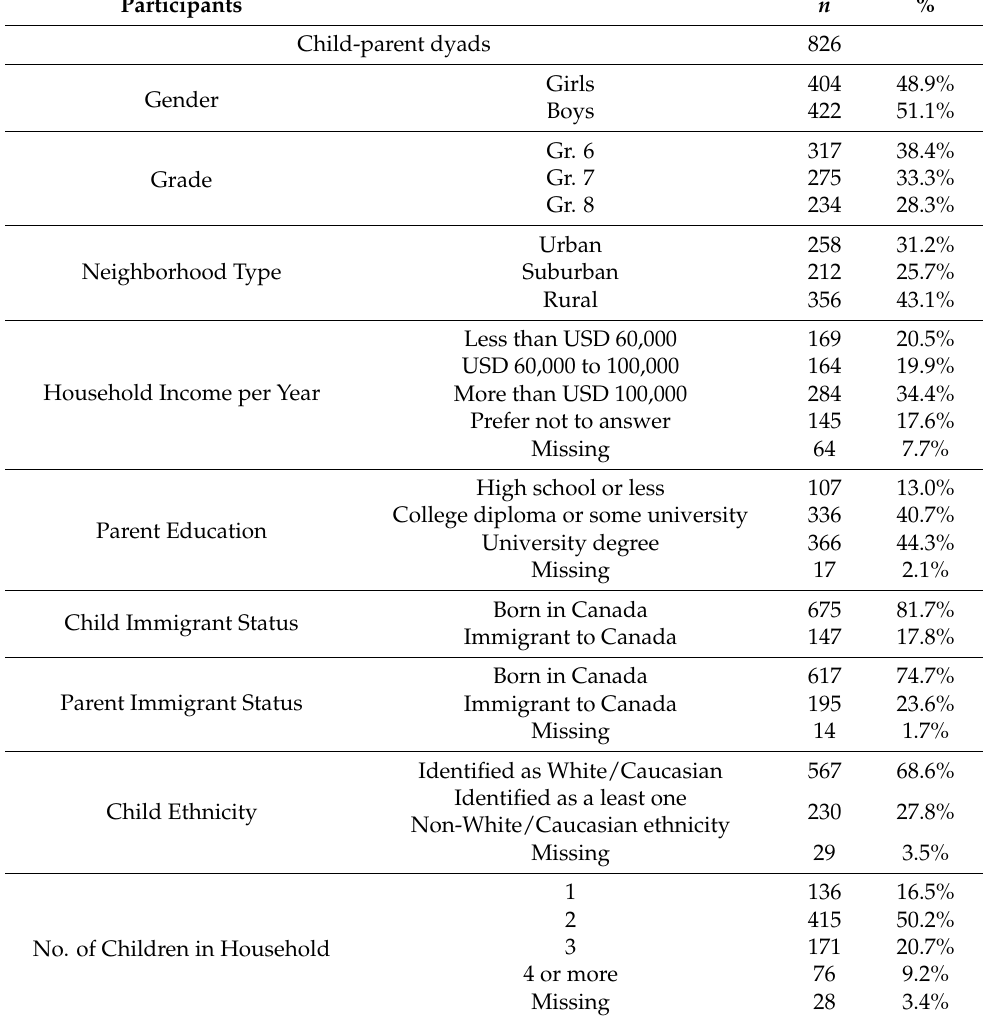
Table 1. Participant